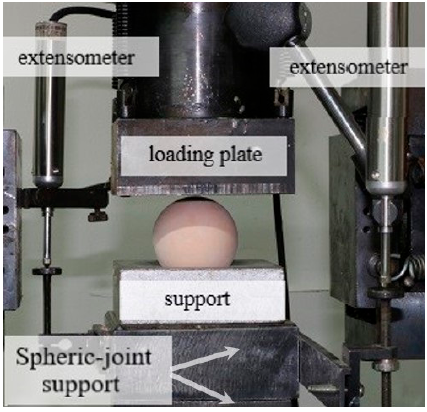
Figure 2. Experimental facilities: ( a ) rock rheological testing system; ( b ) spherical joint support.